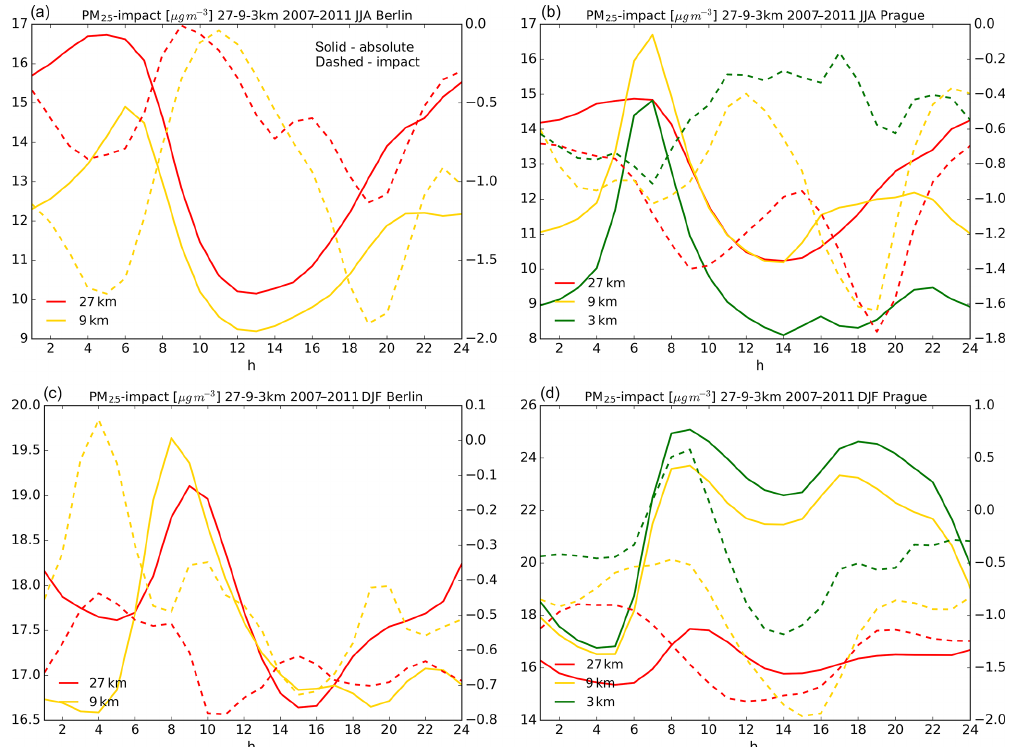
Figure 31. The diurnal cycle of the absolute PM 2 . 5 concentrations (solid; left-hand axis) as well as the total-impact (i.e., the t+q+uv+kv- impact; dashed; right-hand axis) above Berlin (a, c) and Prague (b, d) for JJA (a, b) and DJF (c, d) in µgm − 3 . Red, orange and green colors stand for 27, 9 and 3km resolutions,